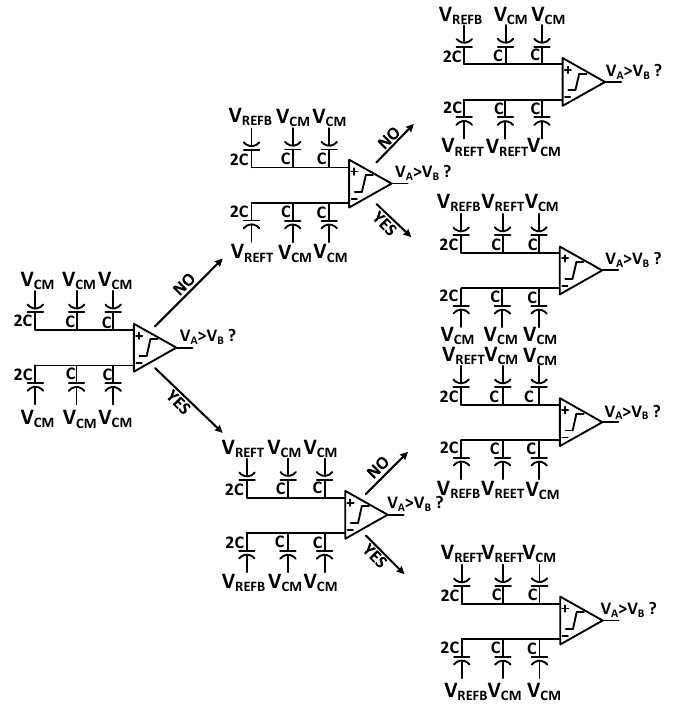
Figure 3. A 3-bit example of CMCR switching scheme.